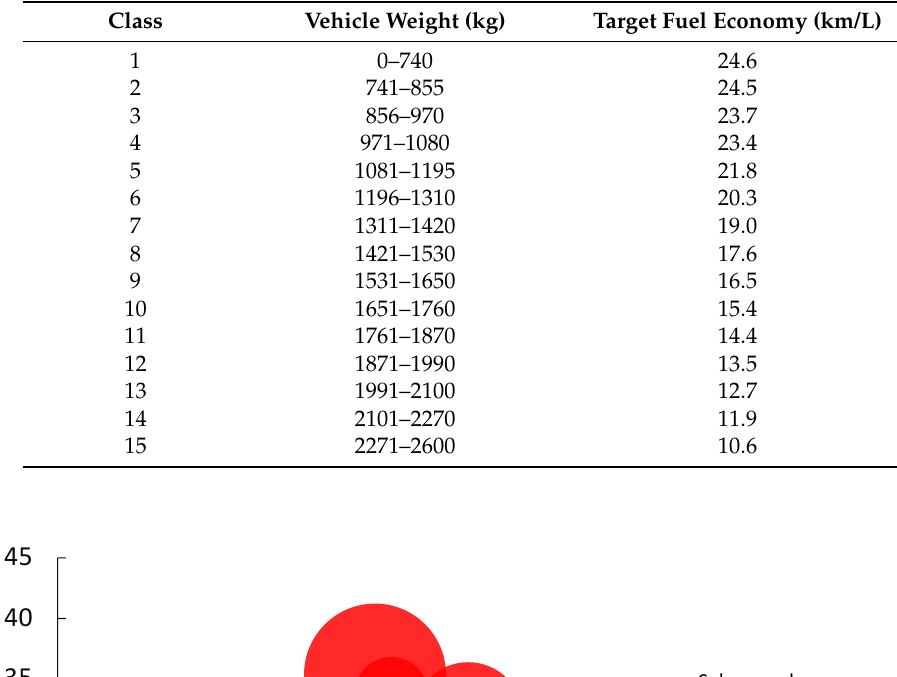
Table A1. Weight categories.